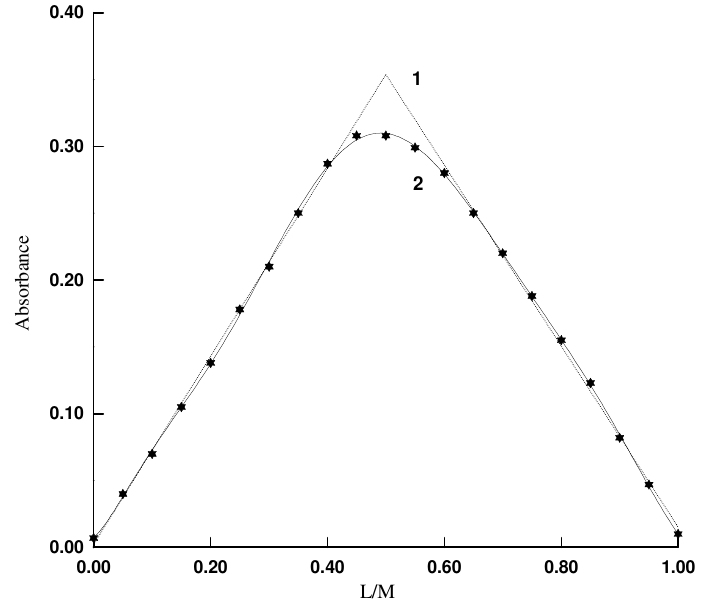
Figure 3 . The continuous variation plot that was fitted as equation of A= -167.609C 9 + 867.991C 8 -1848.76C 7 +2081.33C 6 -1321.74C 5 +468.375C 4 -87.9294C 3 +7.97288C 2 +0.381383C + 0.0074236, (r 2 =0.999588). The extrapolated equations: A = -0.677055C + 0.692218; A = 0.702807C + 0.00233091. The experimental conditions were similar to